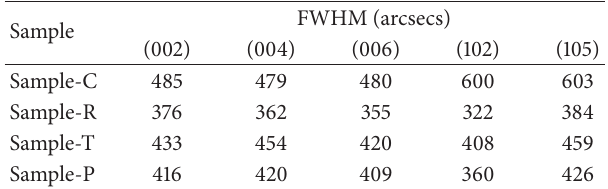
Table 1: Full width at half-maximum values of 𝜔 rocking curves measured by